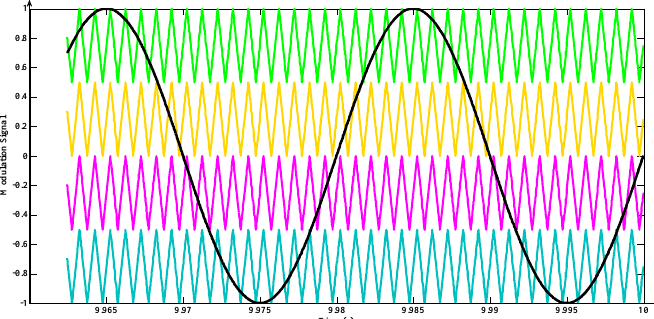
Figure 37. Waveform for alternate phase opposition method.